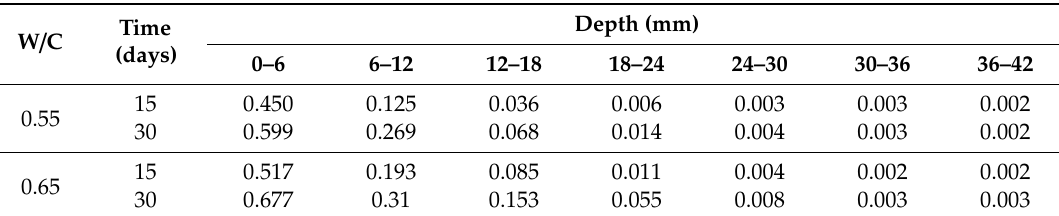
Table 1. Total chloride profile associated with two different water–cement ratio and time period on depth .